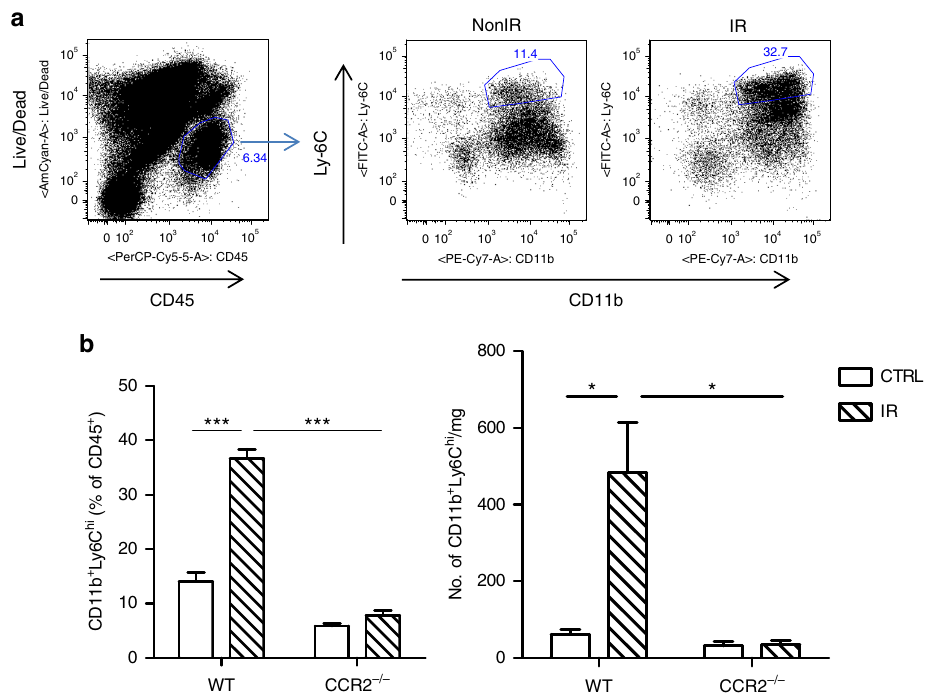
Fig. 1 Monocytic-MDSCs are accumulated in tumors following radiation in WT but not in CCR2 − / − mice. Tumors were harvested 3 days post-IR and subjected to fl ow cytometry analysis. a Gating strategy and b fl ow analysis of Ly6C hi populations in control (NonIR) and irradiated (IR) tumors grown in WT or CCR2 − / − hosts ( n = 4). b Left, cell percentage; Right, absolute cell number. *** P = 0.0001; * P < 0.05, as calculated by two-sided Student ’ s t -test. The experiments were repeated 3 times. Data are presented as mean ±